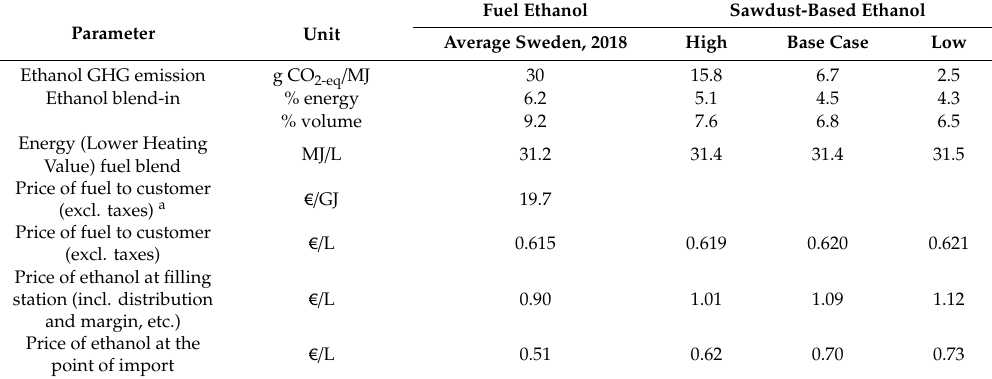
Table 4. Blend-in demand and price of ethanol in the Swedish reduction obligation system 2020.